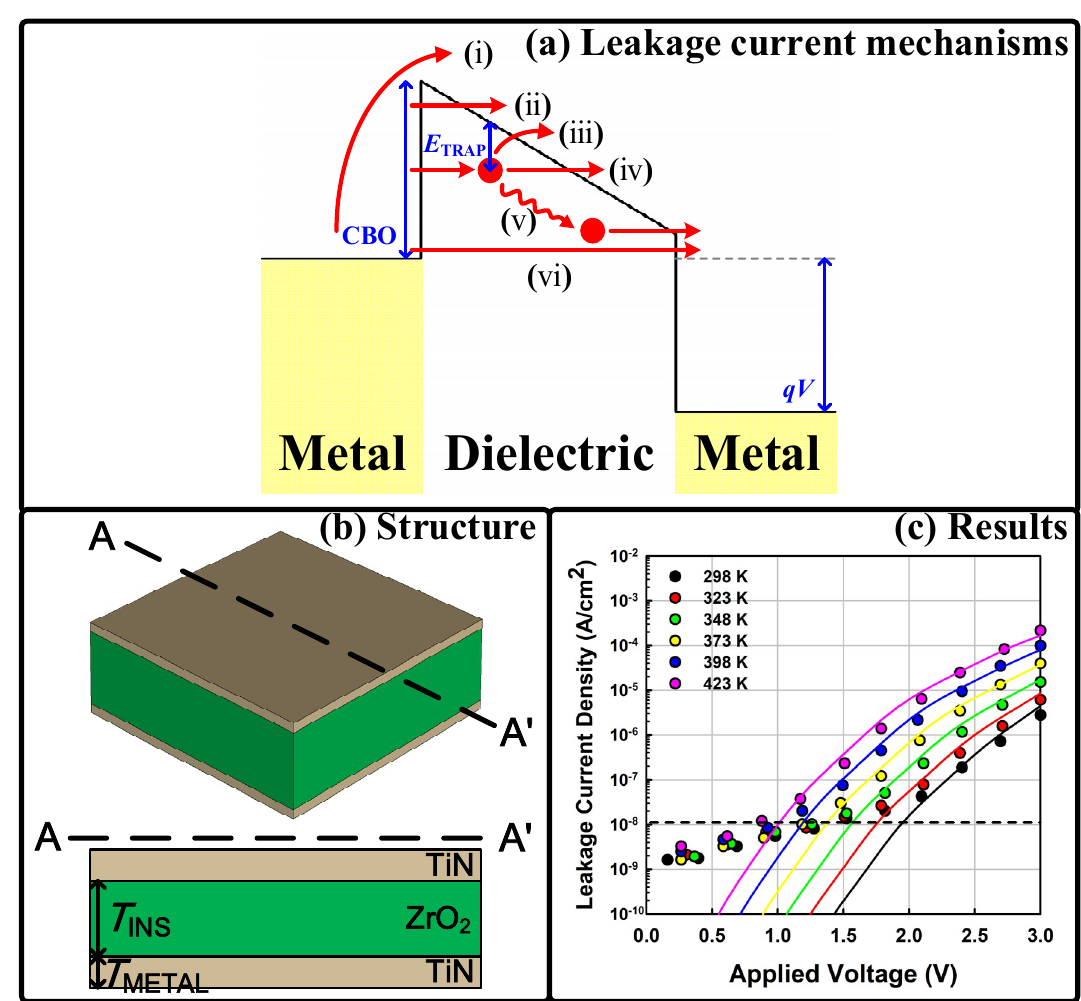
Figure 1. ( a ) Energy band diagram of a metal/insulator/metal (MIM) capacitor, including the possible charge transport mechanisms. CBO: conduction band offset between the metal and dielectric layers. E TRAP is an energy level of a trap state. The red arrows show possible charge transport mechanisms: (i) thermionic emission, (ii) Fowler–Nordheim tunneling, (iii) Poole–Frenkel emission (PFE), (iv) trap-assisted tunneling (TAT), (v) trap-to-trap tunneling, and (vi) direct tunneling. The red circles represent trapped electrons at the trap sites. q and V are the elementary charge and applied voltage, respectively. ( b ) Bird’s-eye and cross-sectional views of a simulated TiN/ZrO 2 /TiN capacitor. ( c ) Calibrated simulation data compared with experimental data [21]. It is worth noting that the leakage current at a low bias is ignored, as only the shallow trap level, which originates from oxygen vacancies, is considered [20].